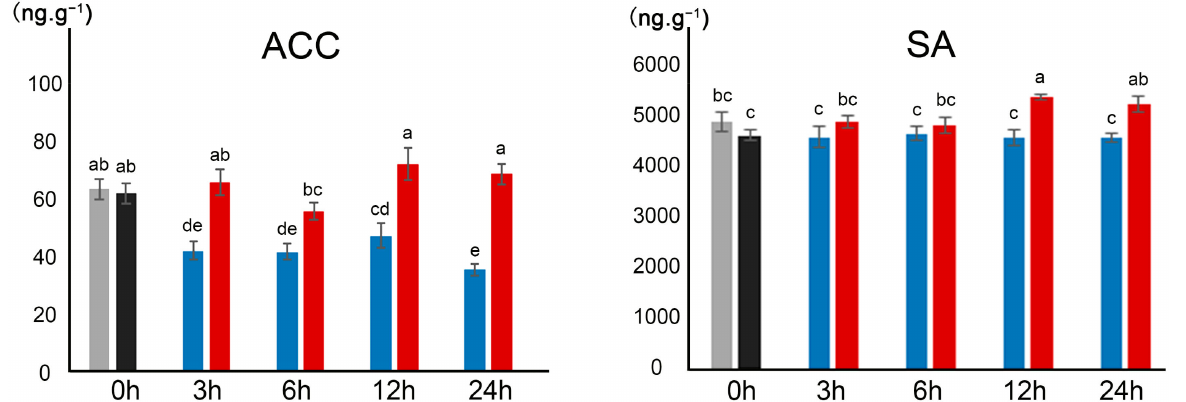
Figure 3. Plant hormones levels between 9311-2x and 9311-4x rice plants under alkaline stress. ABA, JA, IAA, tZ, ACC, and SA were detected at different time points: 0 h (without stress), 3 h, 6 h, 12 h, and 24 h after alkaline stress. The values marked with different letters between two columns are significantly different at p <